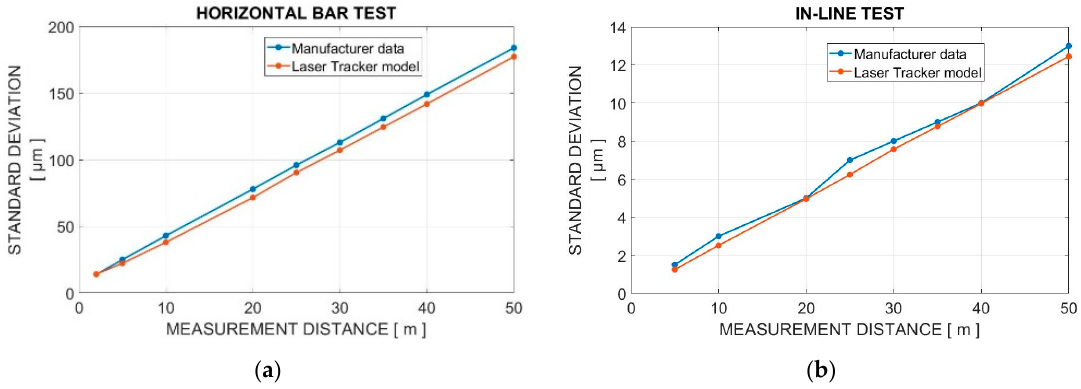
Figure 3. Model parameter fitting of the laser tracker (LT) to the manufacturer data for ( a ) horizontal scale bar test for angular measurement performance and ( b ) distance measurement performance.